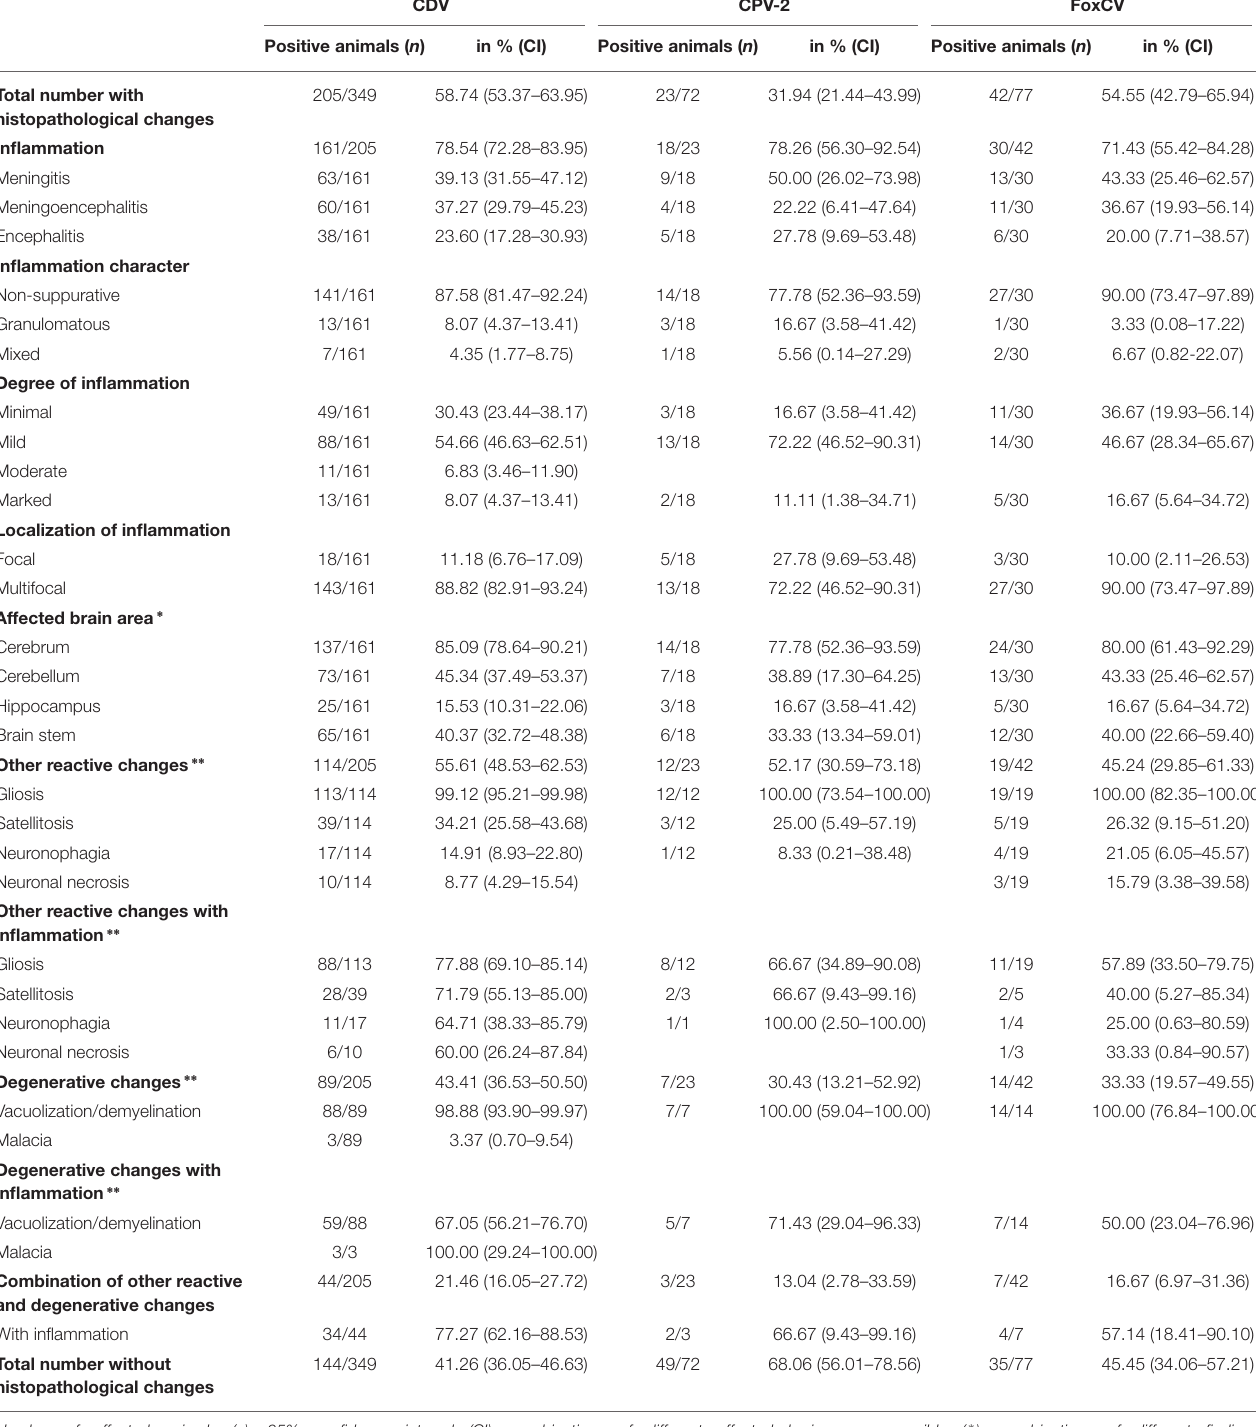
TABLE 1 | Histopathological findings in animals with canine distemper virus (CDV), canine parvovirus type 2 (CPV-2), or fox circovirus (FoxCV), irrespective of possible pathogen